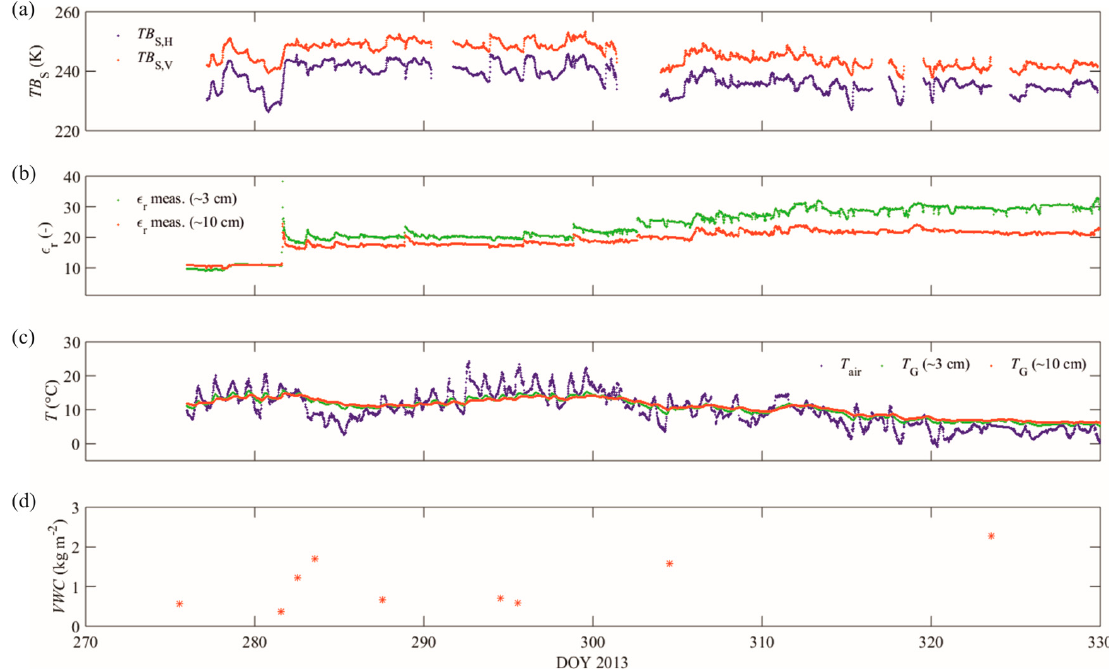
Figure 6. ( a ) ELBARA brightness temperature ( TB S ) at horizontal (blue dots) and vertical (red dots) polarizations as a function of day of the year (DOY) over fifty-four days and with a measurement interval of 15 min; ( b ) soil relative dielectric permittivity ( ε r ) measured by the 5TE sensors at 3 and 10 cm depth; ( c ) soil temperature ( T G ) measured by the 5TE sensors at 3 and 10 cm depth and air temperature ( T air ) measured at the meteorological station; and ( d ) gravimetric vegetation water content ( VWC ) derived from laboratory measurements on vegetation samples.